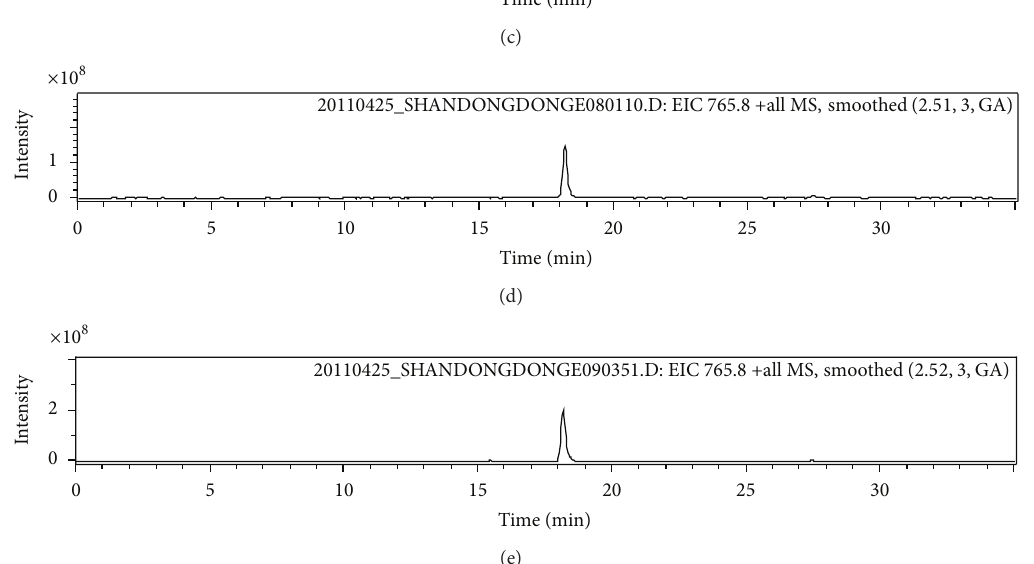
the peaks, with the retention times and the fragments of the characterized species-specific peptides of every kind of gelatin listed in Table